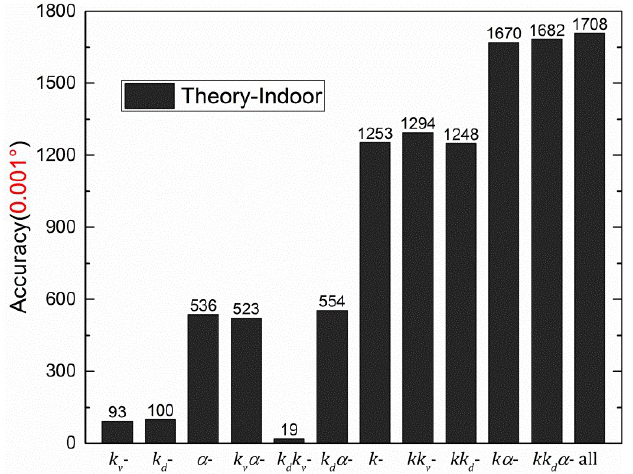
Figure 21. Theoretical calibration parameters replacing the corresponding indoor calibration parameters. Figure21.